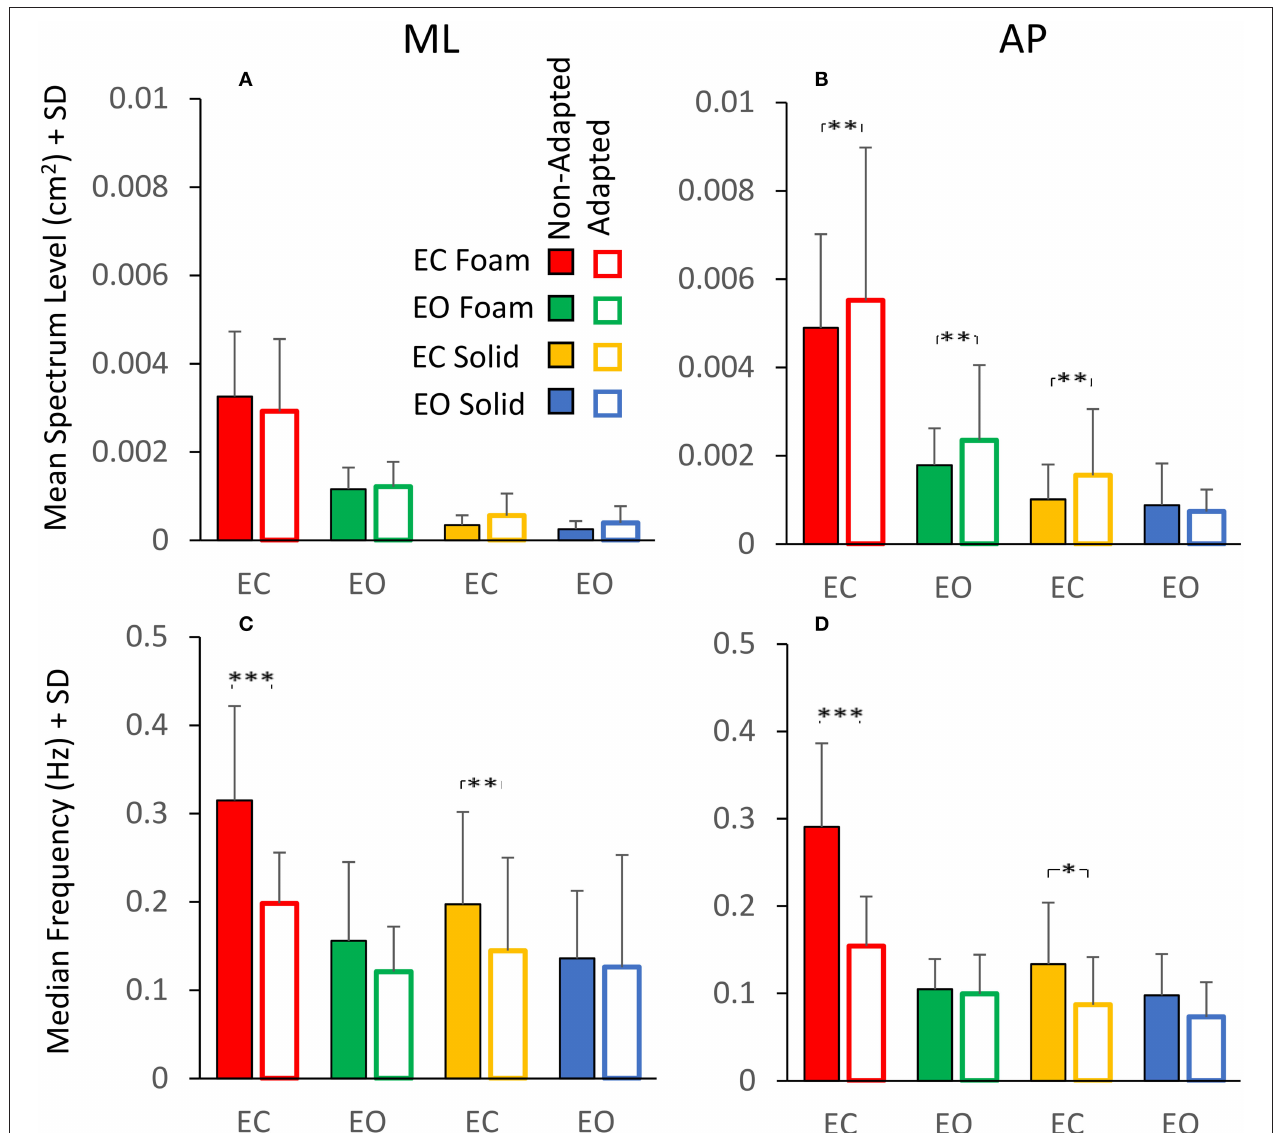
FIGURE 7 | Effect of adaptation on mean Spectrum Level (upper panels) and Median Frequency (lower panels). In the ML direction (A) , the mean Spectrum Level is similar between the non-adapted (filled columns) and the adapted trials (empty columns). In the AP direction (B) , the mean Spectrum Level increases with adaptation, except for the EO Solid condition. The Median Frequency (C,D) moves towards smaller values with adaptation, particularly with EC, for both Foam and Solid supports (red and yellow, respectively). Asterisks indicate significant differences (*, p < 0.05; **, p < 0.01; ***, p <